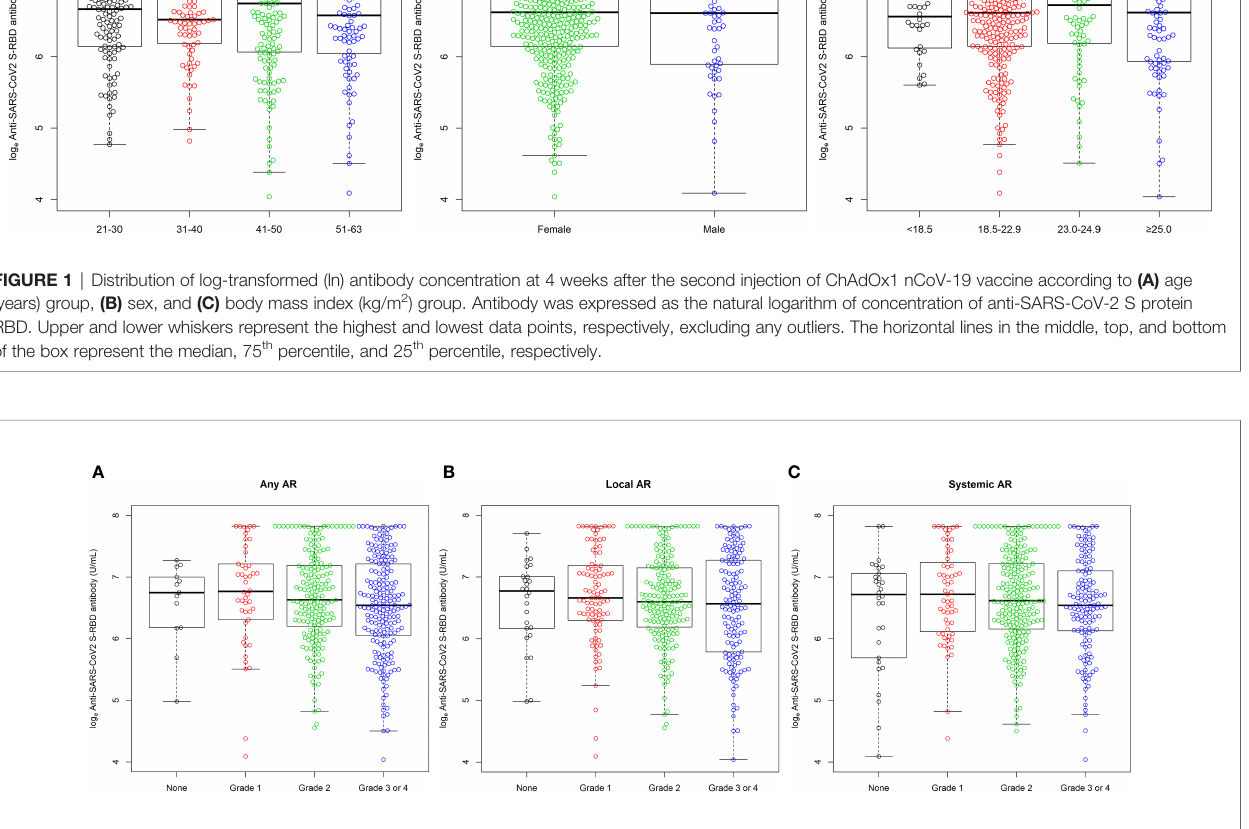
FIGURE 2 | Distribution of log-transformed (ln) antibody concentration at 4 weeks after the second injection of ChAdOx1 nCoV-19 vaccine according to severity of (A) any adverse reactions, (B) local adverse reactions, and (C) systemic adverse reactions to any ChAdOx1 nCoV-19 vaccination. Antibody was expressed as the natural logarithm of concentrations of anti-SARS-CoV-2 S protein RBD. Upper and lower whiskers represent the highest and lowest data points, respectively, excluding any outliers. The horizontal lines in the middle, top, and bottom of the box represent the median, 75 th percentile, and 25 th percentile,